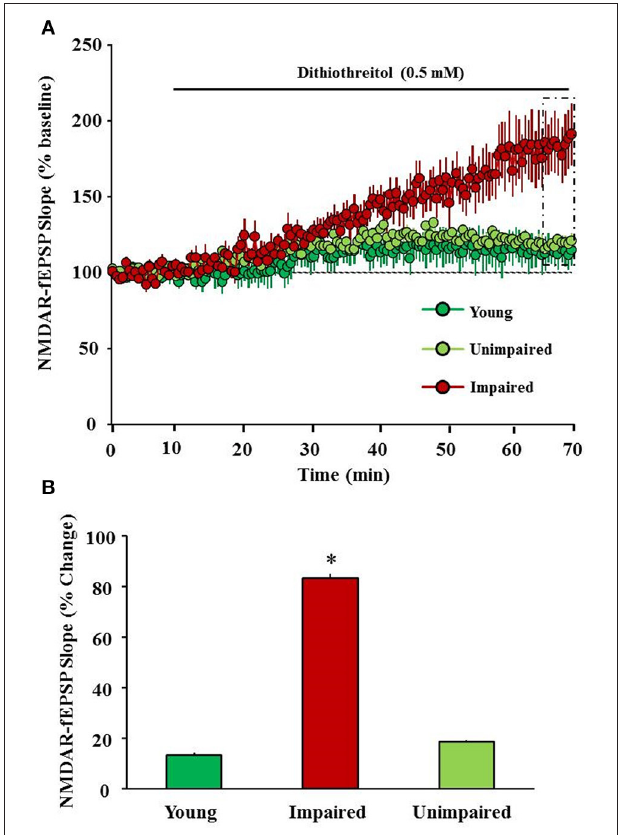
FIGURE 3 | Redox environment contributes to a decline in NMDA receptor function associated with cognitive aging. (A) Time course of changes in the slope of NMDAR-fEPSP obtained from hippocampal slices 10min before and 60min after bath application of a reducing agent, dithiothreitol (DTT, 0.5mM, solid line) for young (green circles), unimpaired (lime green circles), and impaired (red circles) animals. (B) Bar diagram demonstrating percent change in NMDAR-mediated synaptic response following DTT application (5min of last 60min) in slices obtained from young (green), unimpaired (lime green), and impaired (red) animals. DTT induced an increase in NMDAR-mediated synaptic response was significantly higher in slices obtained from impaired animals compared to young and unimpaired animals. * indicates significant